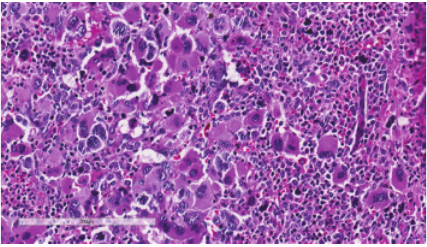
Figure 3: H & E section showing a markedly hypercellular bone marrow with megakaryocytic hyperplasia.